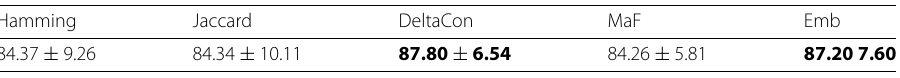
Table 5 Mean and standard deviation of classification accuracies on brain connectomes dataset Hamming